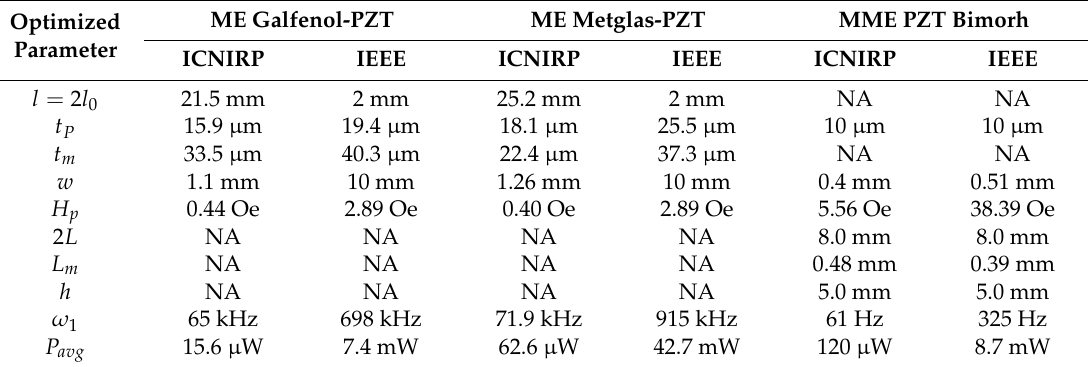
Table 5. Optimization